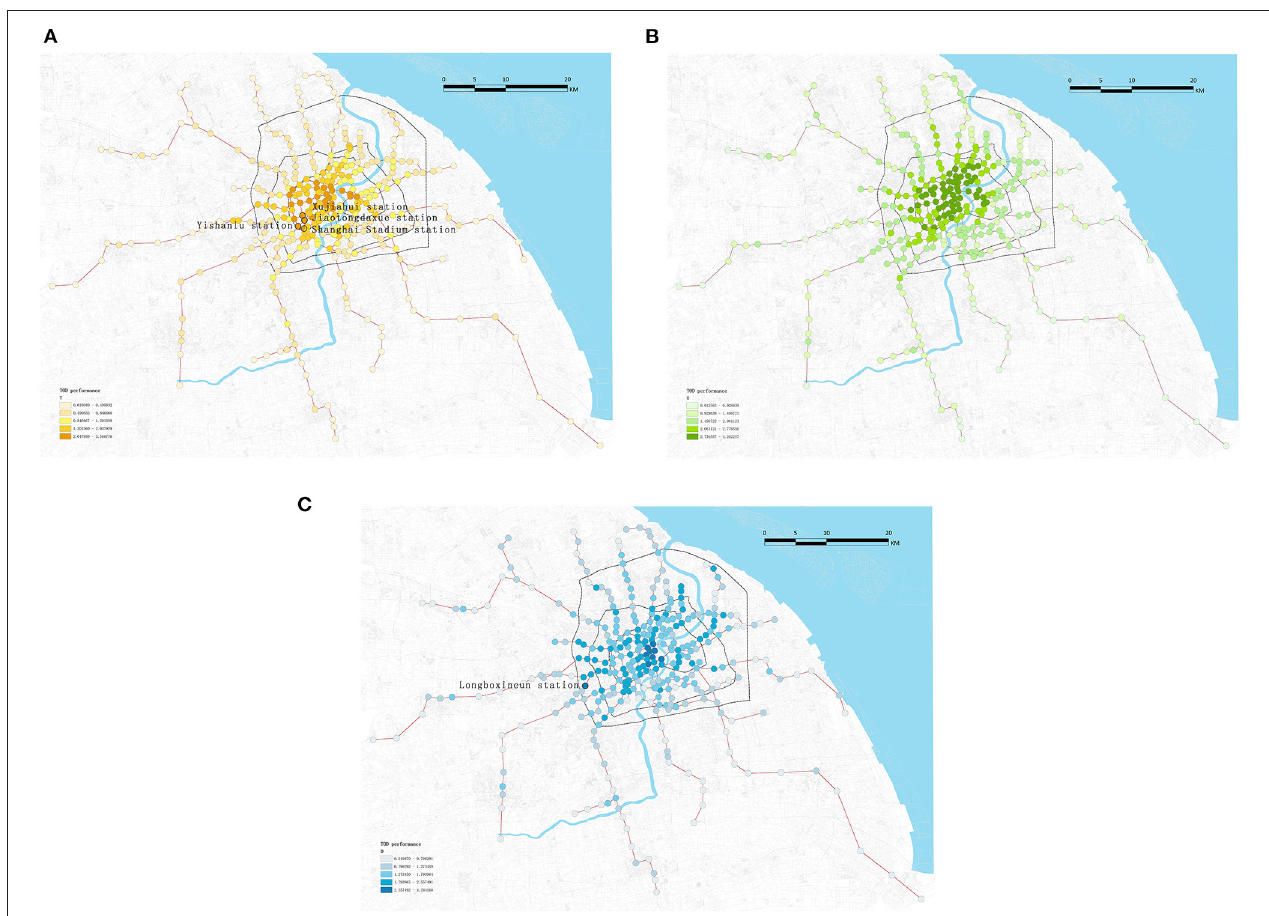
FIGURE 7 | Visualization of (A) Transportation (T), (B) Pedestrian-oriented (O), and (C) Development (D) dimensions of TOD performance (dark color indicating high values and light color representing low values).